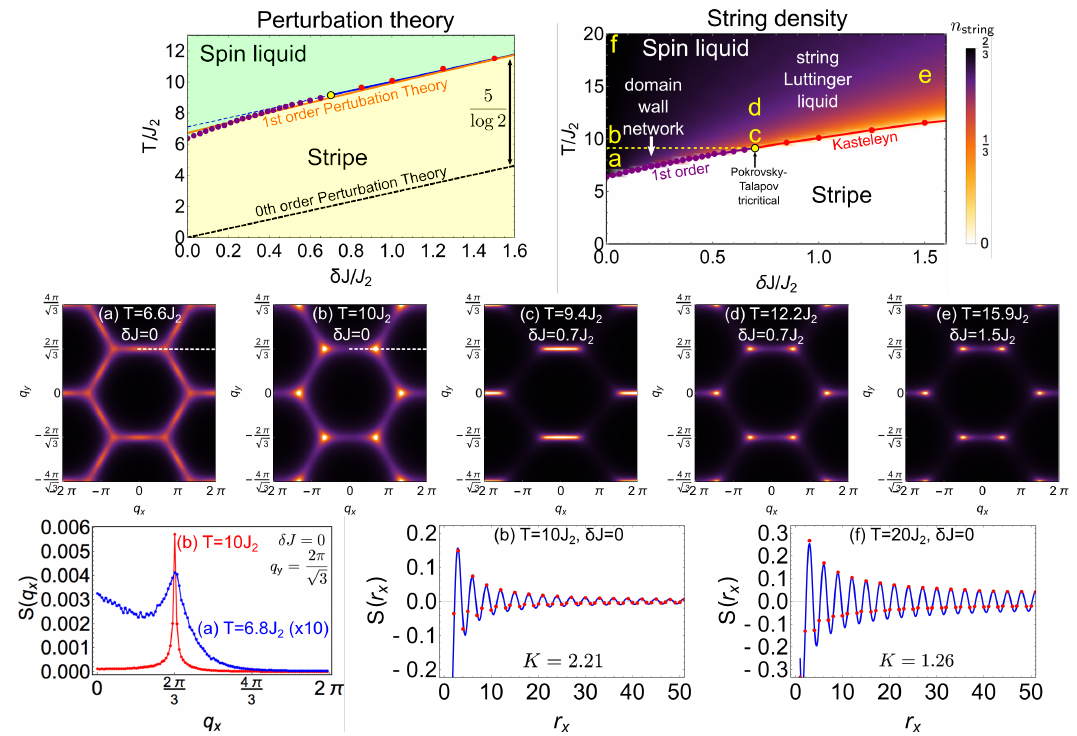
[ Eq. 69 ] in the constrained manifold. Figure 26: The phase diagram and structure factor of H ABB2 (Top) Phase diagram showing the stripe-ordered and spin-liquid phases. First (purple), second (red) and Pokrovsky-Talapov tricritical (large yellow dot) transitions are determined from finite-size scaling analysis of Monte Carlo simulations [ Eq. 87 ] , and in the case of the second-order transition compare well to the exact value (blue solid line). Zeroth (black-dashed) and first-order (orange) perturbation theory calculations of the critical temperature (orange) are shown on the left hand plot (i.e. the temper- = 0 [ Eq. 81 ] ). On the right-hand plot the spin-liquid is split into a string Luttinger ature at which ε HF ( π ,0 ) liquid for T > T tri = 9.14 J and a domain-wall network for T < T tri (separated by dashed yellow line). 2 (Middle) Structure factor S ( q ) calculated by Monte Carlo simulation of an L = 72 hexagonal cluster (letters correspond to those on the phase diagram). (Bottom) Cuts through both S ( q ) and S ( r ) . (a) For δ J = 0 and close to the first-order phase transition S ( q ) has significant spectral weight around the perimeter of the triangular-lattice Brillouin zone, as is typical of a domain-wall network. (b) On in- (cid:112) creasing the temperature spectral weight rapidly accumulates at q = ( ± 2 π/ 3,2 π/ 3 ) , as is typical for a string Luttinger liquid. In the whole string Luttinger liquid region the asymptotic form of S ( r ) follows Eq. 90 with a parameter-dependent Luttinger parameter, K ≥ 1. (c) At temperatures just above the Pokrovsky-Talapov tricritical point, there is a near-degeneracy between string sectors and the structure factor therefore shows extended spectral weight in the q x direction. (d) Further increasing the tem- (cid:112) perature breaks this quasi-degeneracy and sharp peaks form at q string ( T ) = ( ± π n string ,2 π/ 3 ) . (e) At temperatures just above the second-order transition the structure factor is sharply peaked at q string ( T ) . (f) For T (cid:29) J the behaviour of the nearest-neighbour TLIAF in the constrained manifold is recovered, 2 with K =